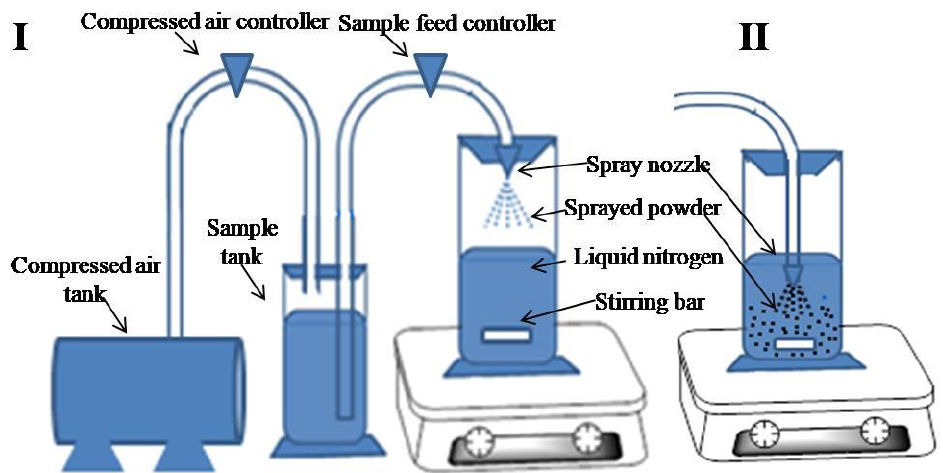
Figure 5. Schematic diagram of spray freeze drying process; ( I ) spray liquid in the liquid N 2 vapor, ( II ) spray of liquid in the bed of liquid N 2 ; ( III ) SEM images of some spray freeze-dried products ( A ) Tolbutamide, ( B ) HPMC and spray-freeze- drying (SFD) of ( C ) 0.9% solute concentration, ( D ) 1.8% solute concentration, ( E ) 9.0% solute concentration, ( F ) 13.5% solute concentration, ( G ) close-up surface image of ( F ), ( H ) internal image of ( F ), and ( I ) close-up image of ( H ). Reproduced